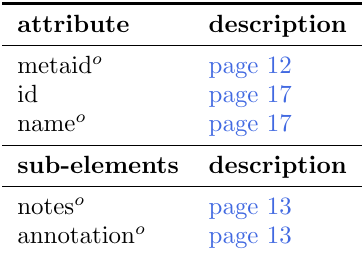
Table 2.18 shows all attributes and sub-elements for the abstractTask element.